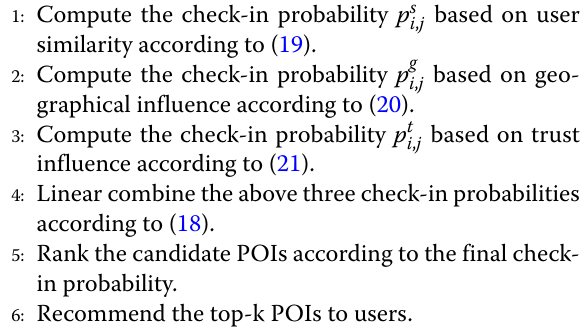
Algorithm 3 Hybrid POI Recommendation